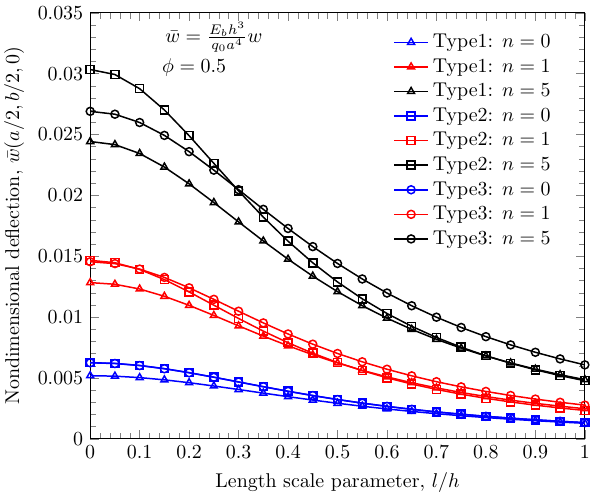
(cid:16) (cid:17) a , b ,0 versus length scale parameter l / h along a 2 2